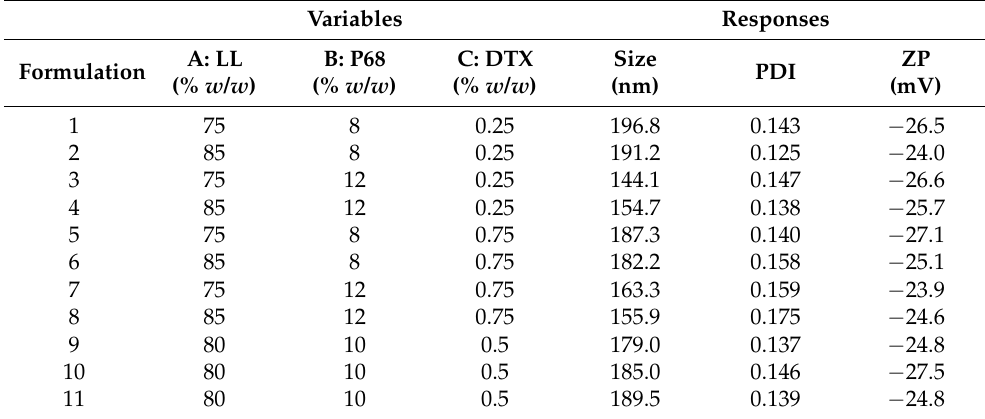
Table 1. Results obtained from the 2 3 factorial design of NLC DTX , showing the independent (LL, P68 and DTX) and dependent variables (responses): size, PDI and ZP. The independent variables are also identified by capital letters: A = LL, B = P68, C = DTX. Variables Responses